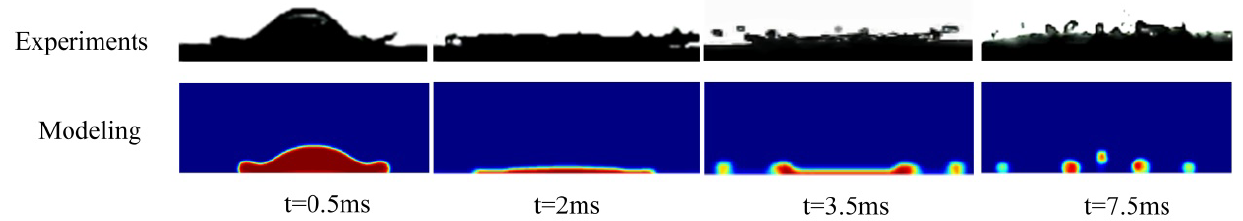
Figure 3. Comparison between the experimental data and the numerical simulations.